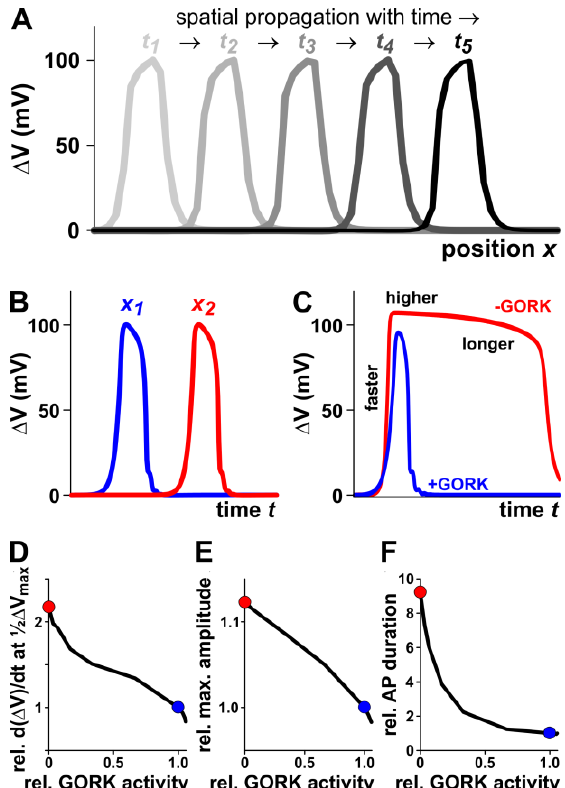
Figure 4. Computational simulation of plant action potentials displayed in a qualitative manner. ( A ) An action potential induced by a short electrical stimulus then propagates in a self-amplifying manner along the ‘green cable’. Displayed is the calculated membrane voltage for a segment of the cable for five different time points (different grey shades). ( B ) At two different positions x 1 (blue curve) and x 2 (red curve) the APs pass at different times. ( C ) Effect of the presence (blue curve) or absence (red curve) of the K + conductance of the GORK channel. A ‘green cable’ without GORK channels has APs that rise faster, reach a higher maximal amplitude and last longer. ( D ) Dependency of the steepness of the initial phase of an AP on the activity of the repolarising K + conductance. ( E ) Dependency of the maximal amplitude of an AP on the activity of the repolarising K + conductance. ( F ) Dependency of the duration of an AP on the activity of the repolarising K + conductance. The red and blue dots in ( D – F ) represent the two situations displayed in ( C ).